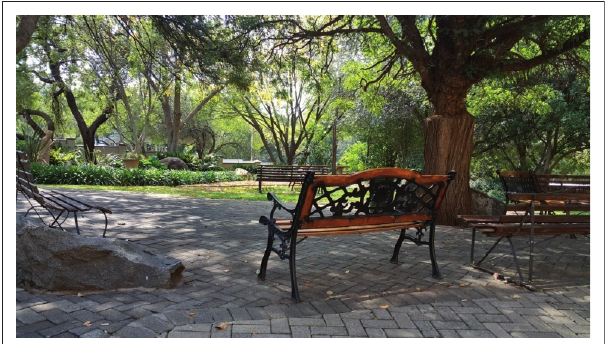
FIGUUR 7: Vriendelike tuine waar die kinders kan sit.